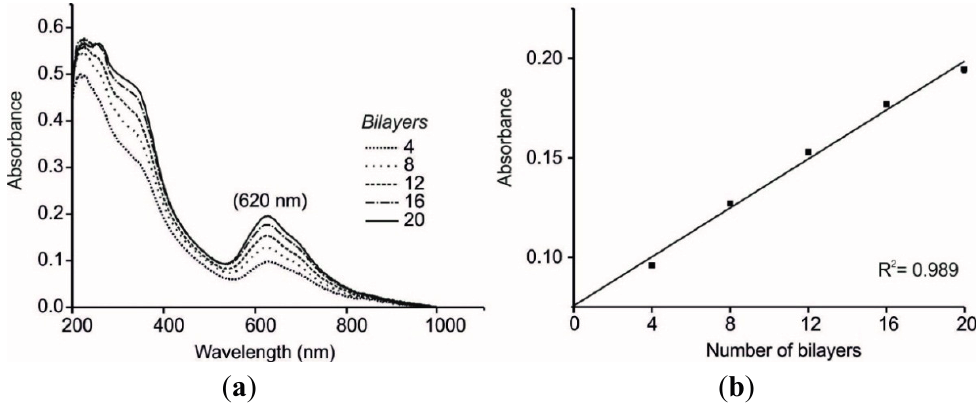
Figure 1. UV-Vis characterization of 4–20 CuPc SO3 /PAH LbL bilayers. ( a ) UV-Vis absorption spectra; ( b ) Linear correlation between absorbance vs . number of